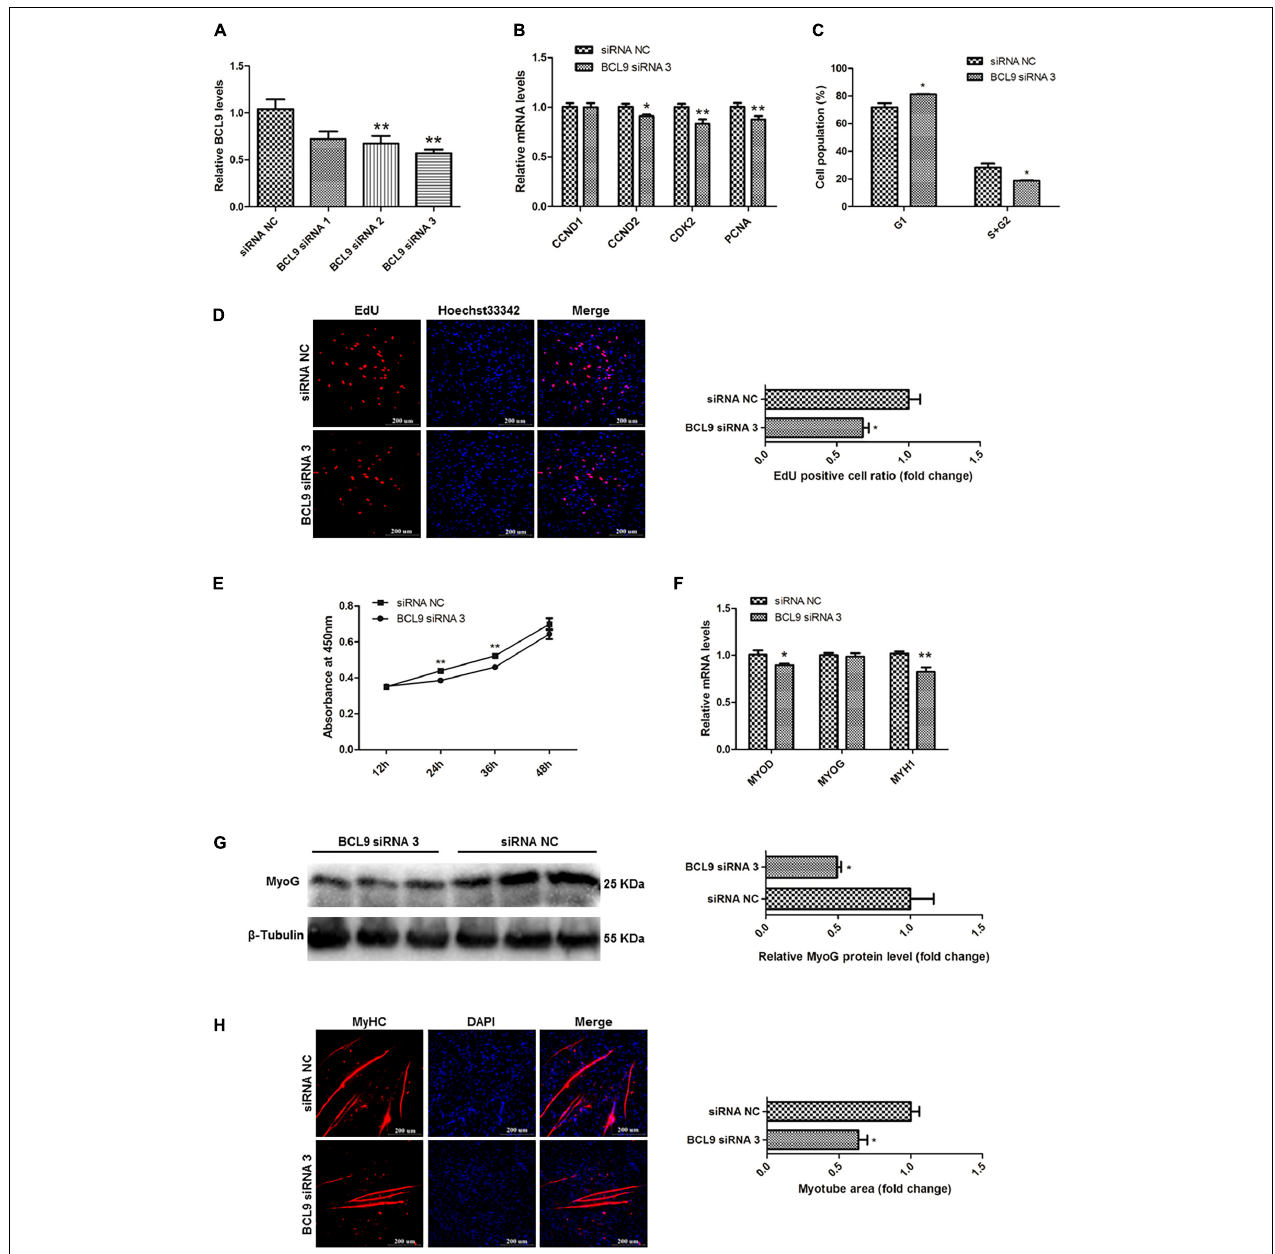
FIGURE 8 | BCL9 promotes the proliferation and differentiation of SMSCs in chicken. (A) BCL9 expression levels in SMSCs with three siRNAs or siRNA NC were transfected. (B) Proliferation-related genes mRNA levels were determined using qPCR after SMSCs were transfected with interfered BCL9. (C) Cell cycle analysis of SMSCs following BCL9 inhibition. (D) EdU assays were conducted after the cells were transfected with BCL9 siRNA 3. (E) SMSCs absorbance at 450 nm was detected by CCK-8 assay after BCL9 was inhibited. (F) Differentiation-related genes mRNA levels were determined using qPCR after SMSCs were transfected with interfered BCL9. (G) MyoG protein levels were detected by western blot after BCL9 were interfered in SMSCs. (H) Myotube areas were calculated at 72 h after BCL9 was interfered in SMSCs. The scale bar represents 200 µ m. Values represent as means ± S.E.M. of three biological replicates. * P < 0.05; ** P <